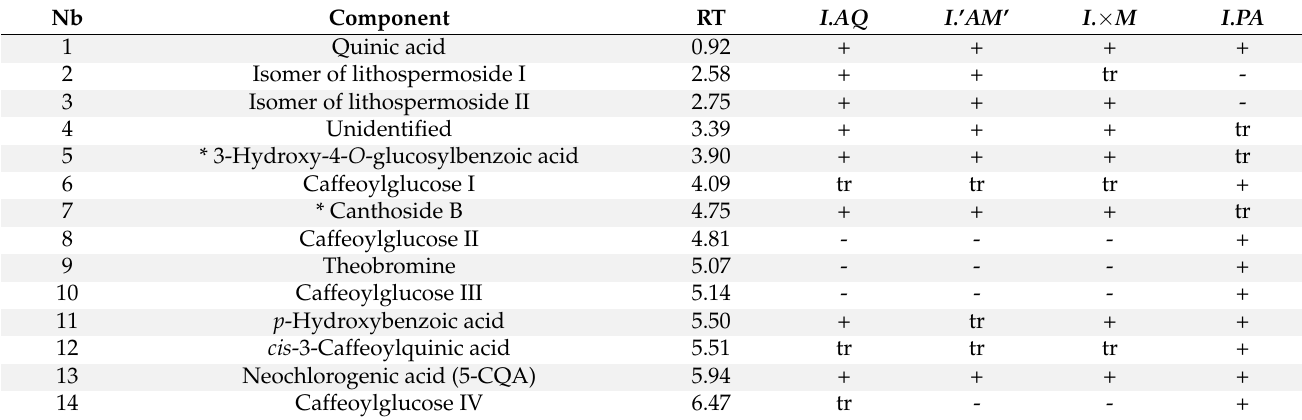
Table legend; NB—number; RT—retention time; * tentatively identified component (lack of accurate spectral literature database; suspected isomer of a known component or unclear UV spectrum); a component identified by comparison with a standard; b component identified by comparison of UV and/or MS/MS spectra with literature; c component identified by prediction with MS/MS spectra;—lack of experimental UV spectra/ions or not applicable. Table 2. Presence of components in Ilex leaves water